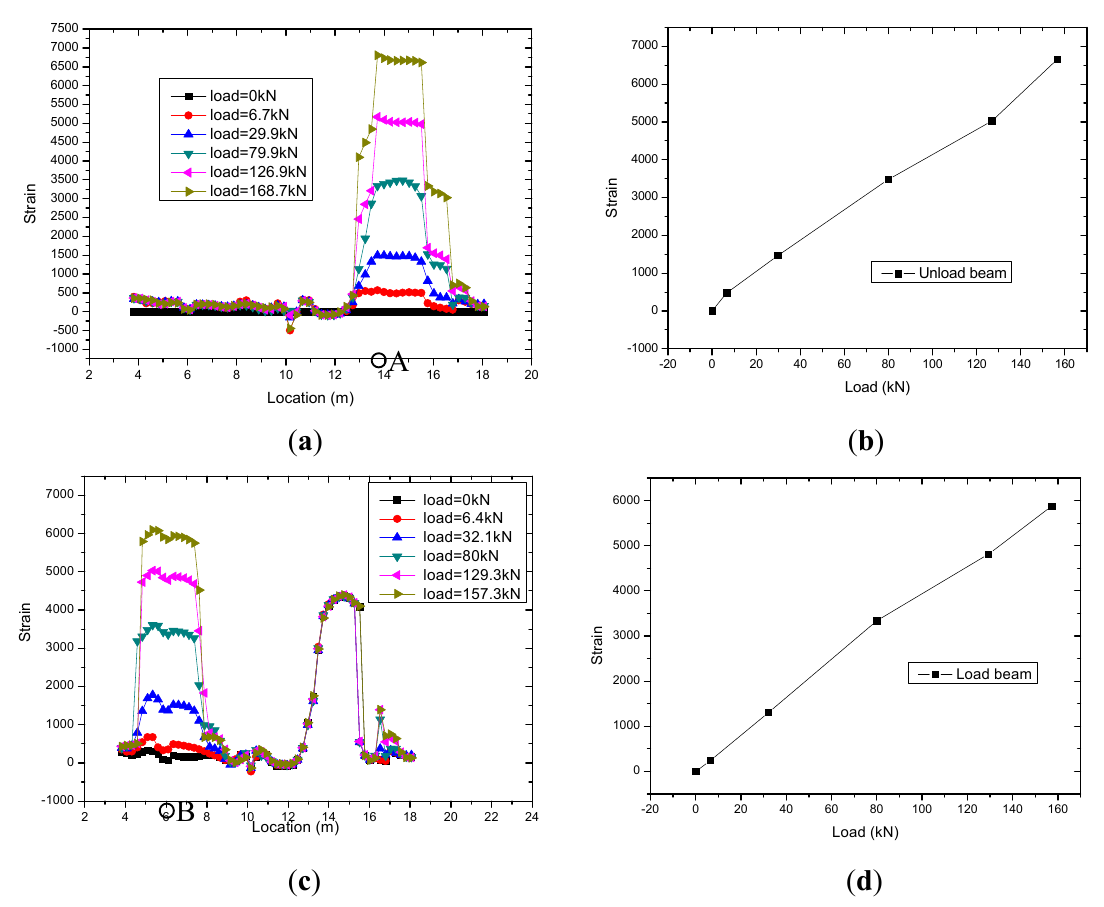
Figure 10. Strain results during the tensioning operation monitored by BOTDA sensors in the smart strand. ( a ) Results of unloaded beam; ( b ) Results of point A; ( c ) Results of loaded beam; ( d ) Results of point